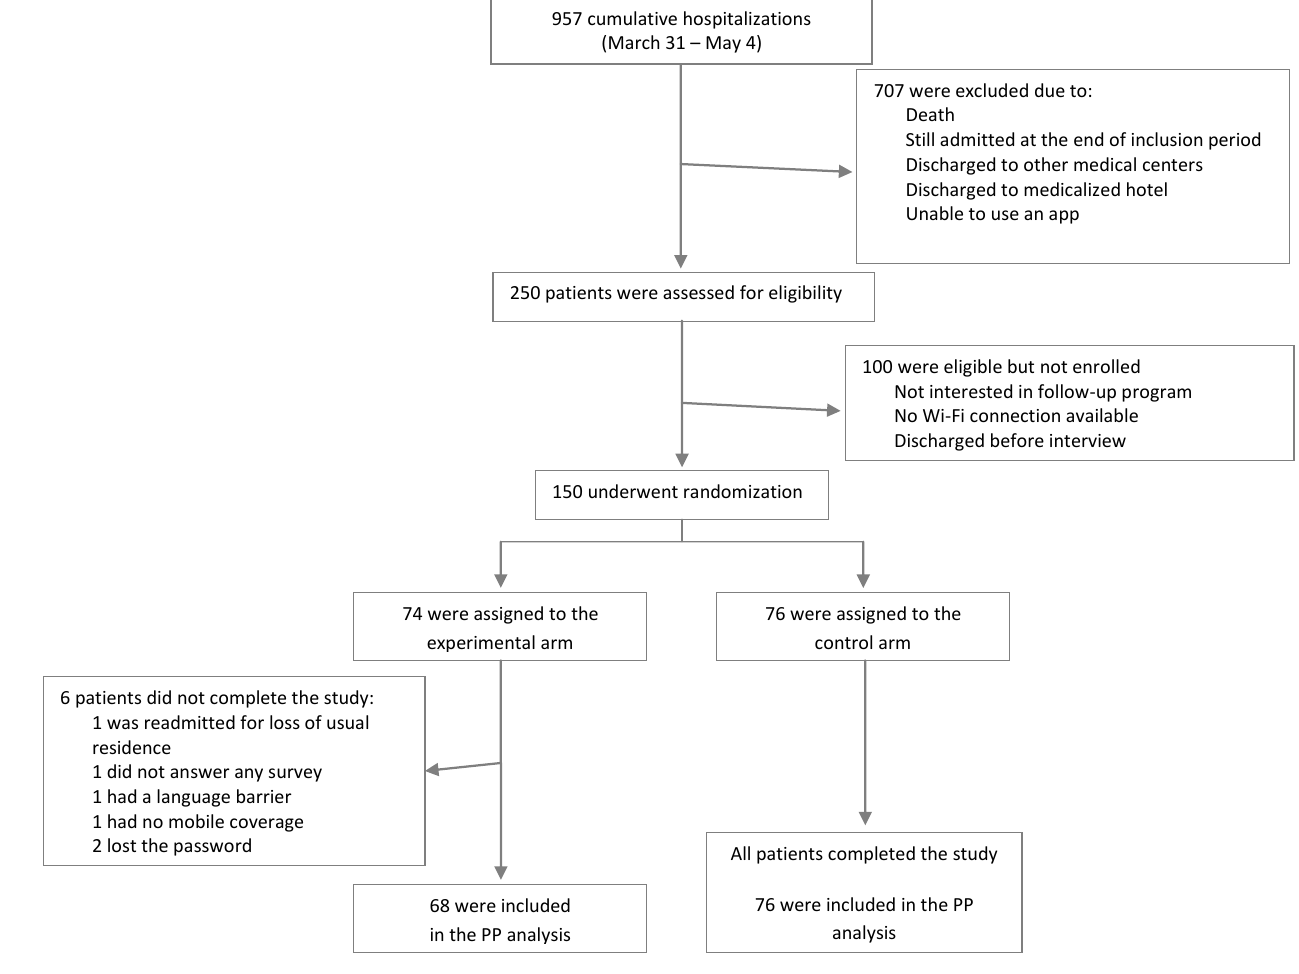
Figure 2. Enrollment and randomization. Table 2. Demographic and clinical